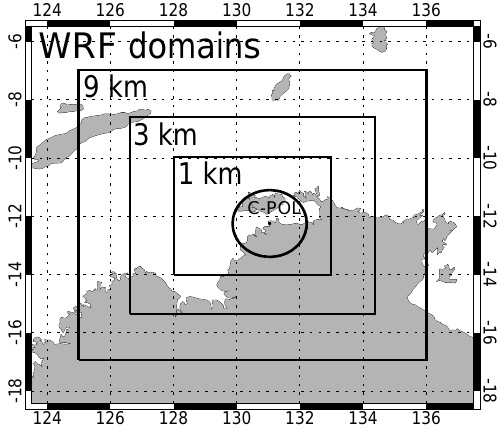
Figure 2. The WRF domains used for the 18 February 2014 simula- tion. The circle indicates the 150km range ring of the C-POL radar located at Gunn